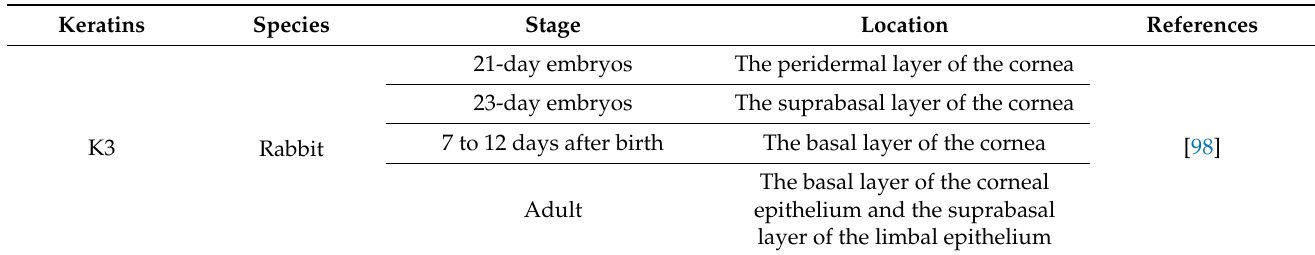
Table 1. Corneal keratins in the development and wound healing of corneal and limbal epithelia.